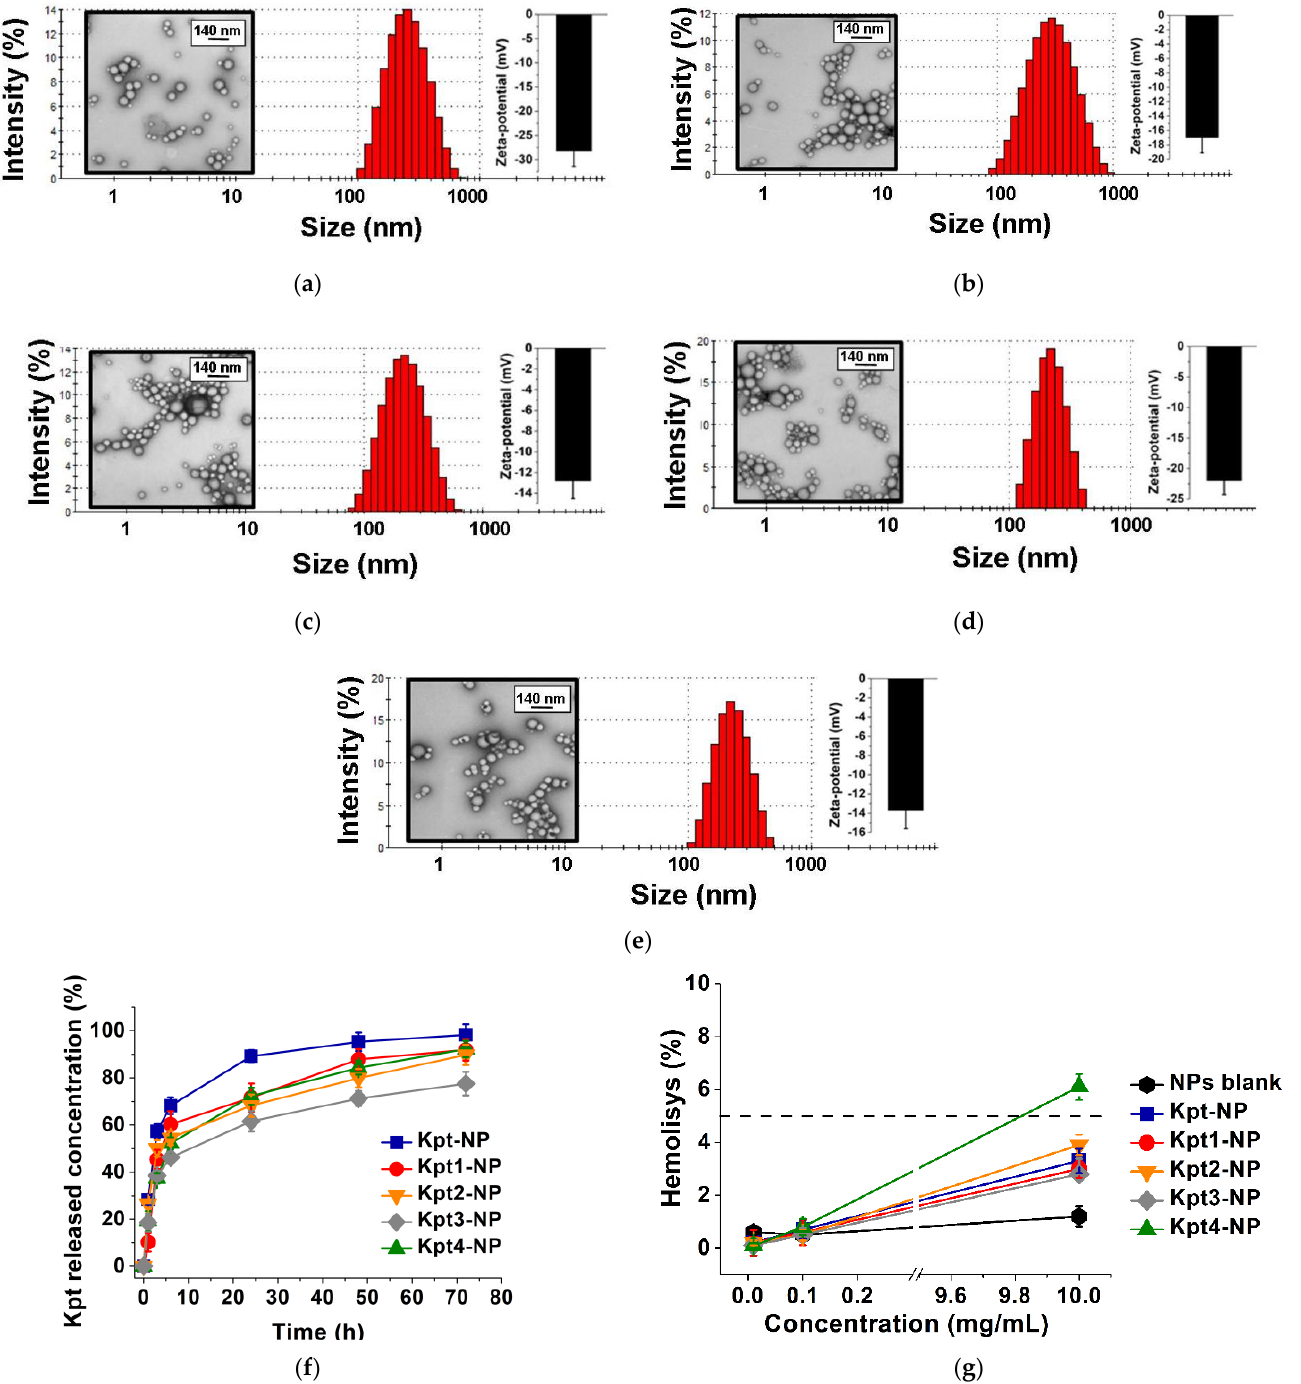
Figure 9. Size distribution, ζ -potential and TEM results of NPs: ( a ) Kpt-NP, ( b ) Kpt1-NP, ( c ) Kpt2-NP, ( d ) Kpt3-NP, ( e ) Kpt4-NP; ( f ) in vitro release profiles of Kpt and Kpt1-4 from NPs in 0.01M PBS pH 7.4. Each point shows mean ± SD ( n = 3); ( g ) hemolytic activity of designed NPs (mean ± SD, n = 3).